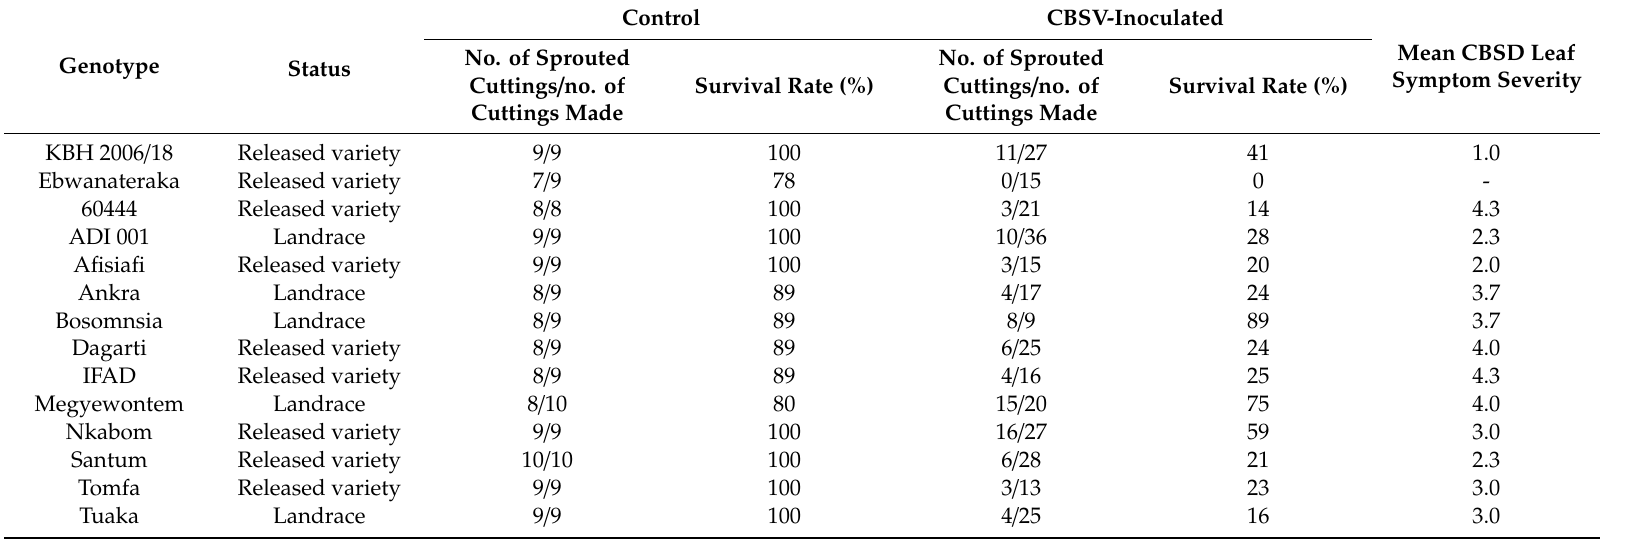
Mean CBSD Leaf Symptom